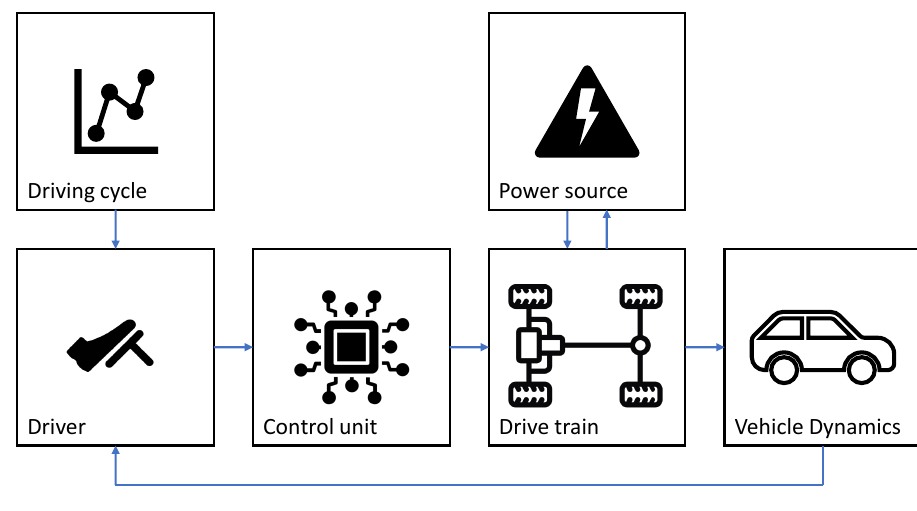
Figure 8. Topology of the VLDM (own representation adapted from